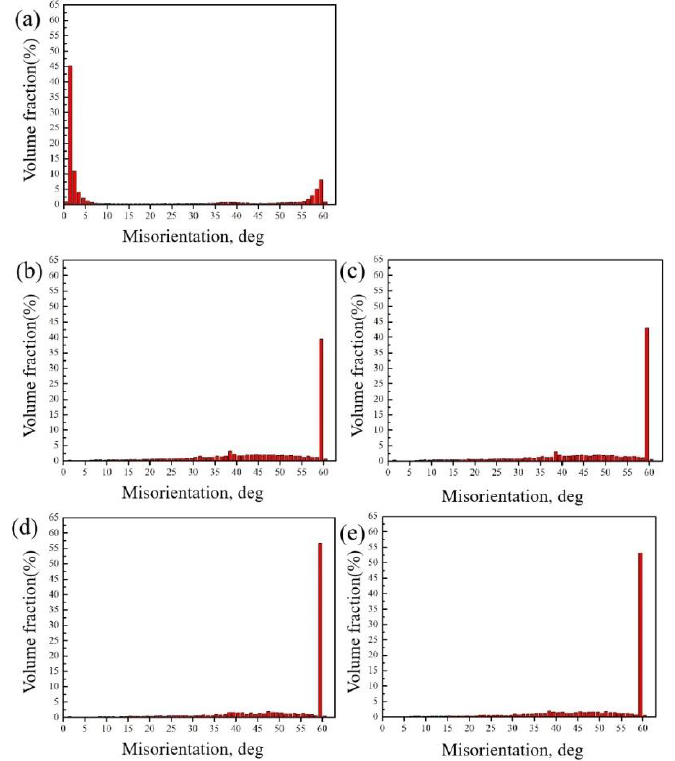
Figure7. Misorientation of cold-rolledand annealedCu-2.7Be samples: ( a ) coldrolled; ( b ) 650 ◦ C / 15 min; ( c ) 650 ◦ C / 1 h; ( d ) 770 ◦ C / 15 min; ( e ) 770 ◦ C / 1